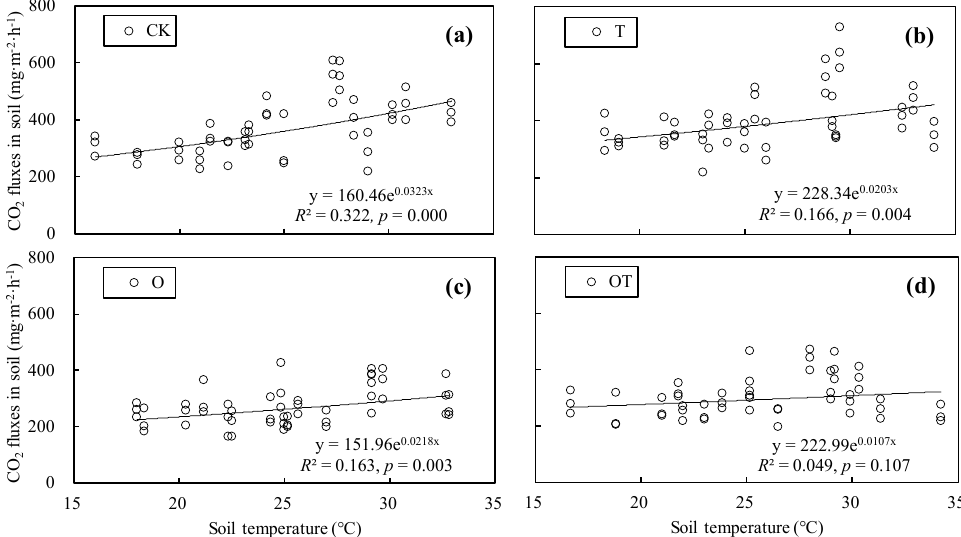
Figure 6. Relationship between soil respiration rates and soil temperature in soybean farmland under different treatments. ( a ), ( b ), ( c ), and ( d ), the relationship between soil respiration rates and soil temperature in soybean farmland under the CK, T, O, and OT treatments, respectively.